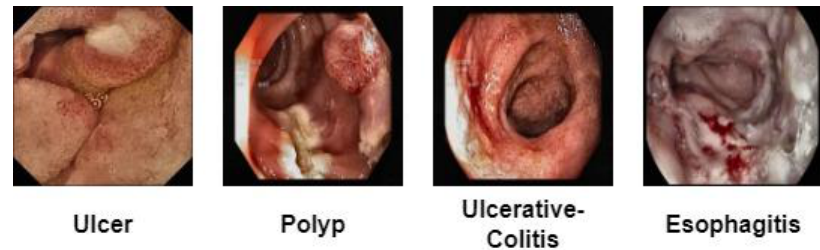
Figure 3. Images after applying our proposed contrast - enhancement